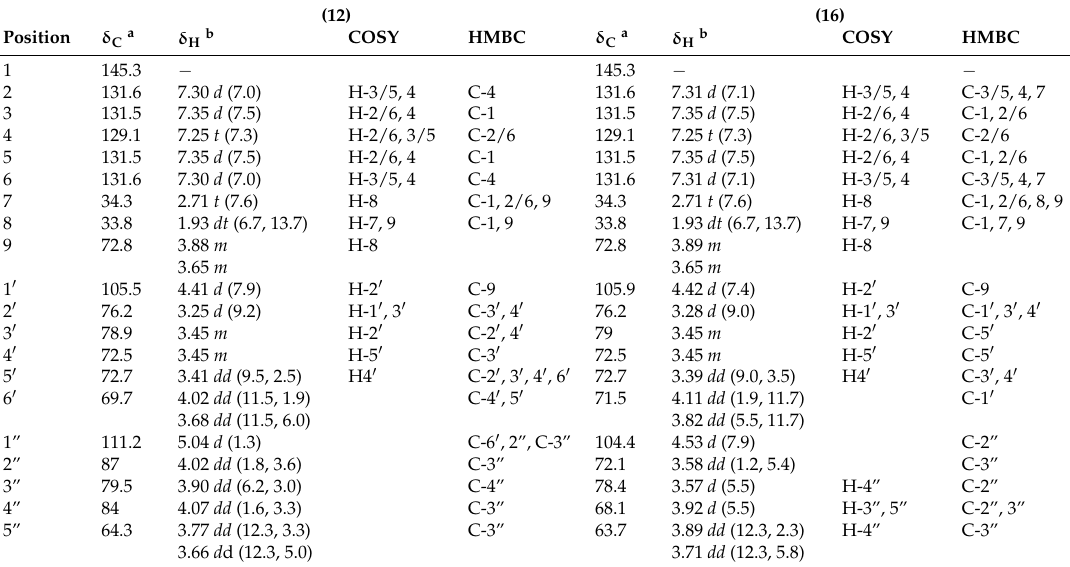
Table 5. NMR data of dihydro–rosarin ( 12 ) and dihydro–rosavin ( 16